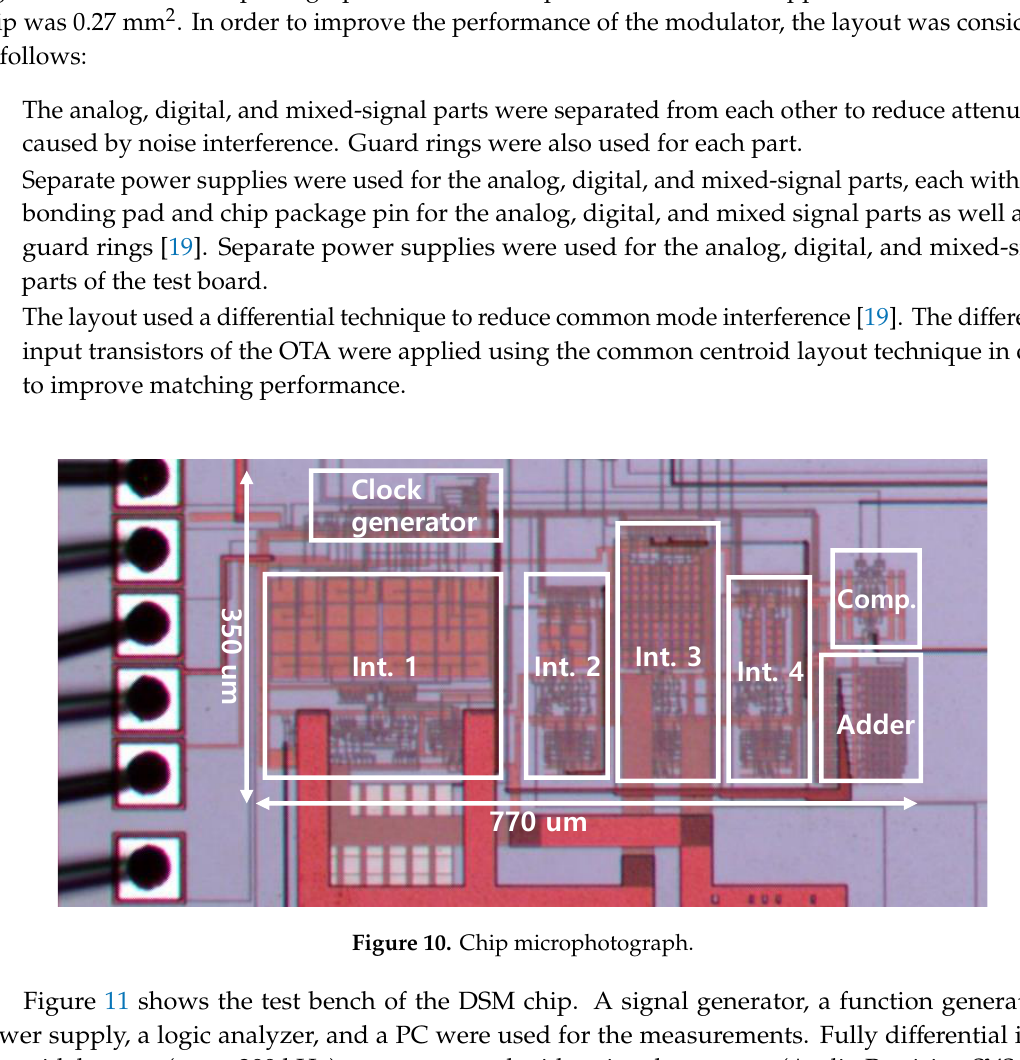
Figure 11. Test bench.